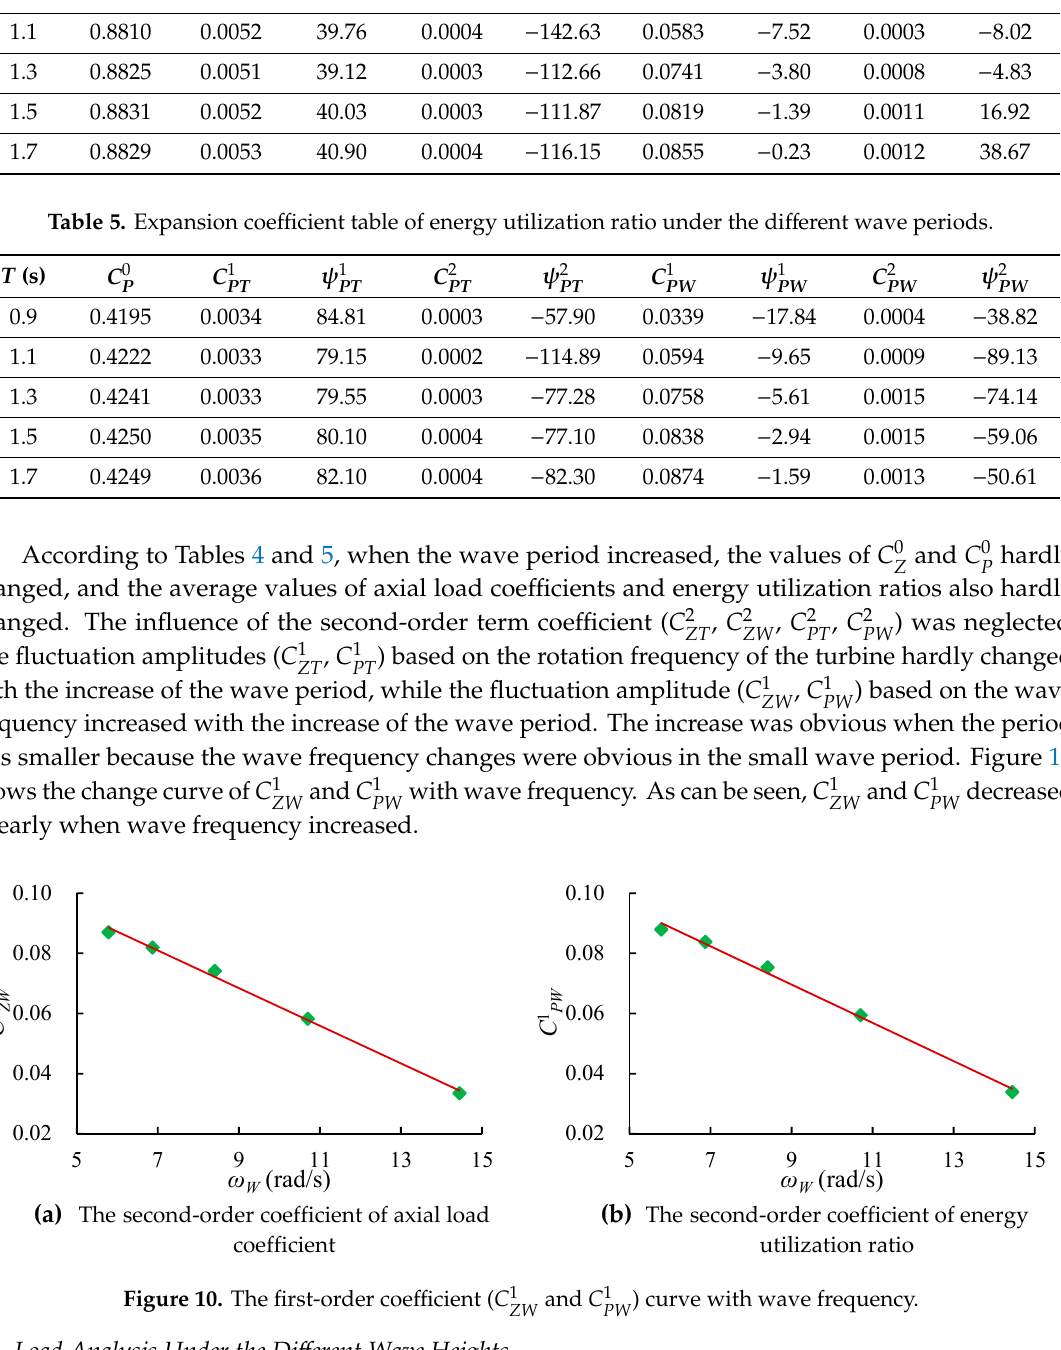
Table 5. Expansion coefficient table of energy utilization ratio under the different wave periods.